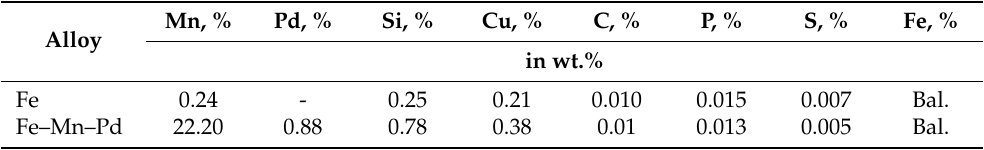
Table 1. Chemical